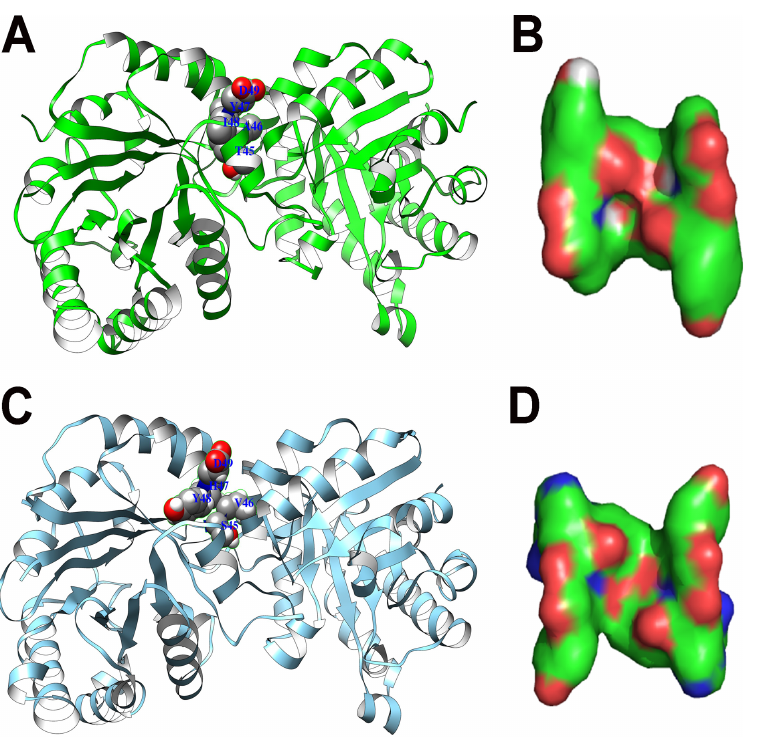
Figure 2 Dimer interface residues TPI. (A) The dimer interface of human TPI enzyme and (B) elec- trostatic potential surface of key residues (A45-I48). (C) The dimer interface of Plasmodium TPI enzyme and (D) electrostatic potential surface of some key residues (V45-Y48).